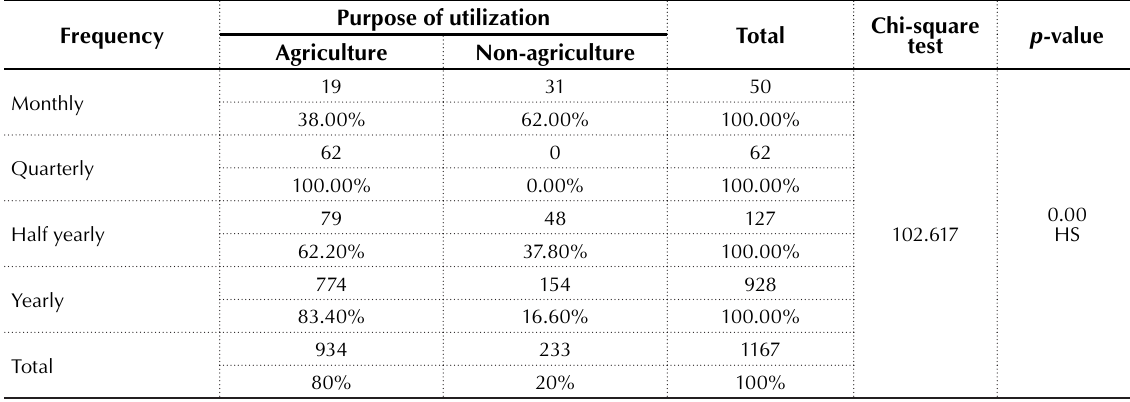
Source: Primary data.